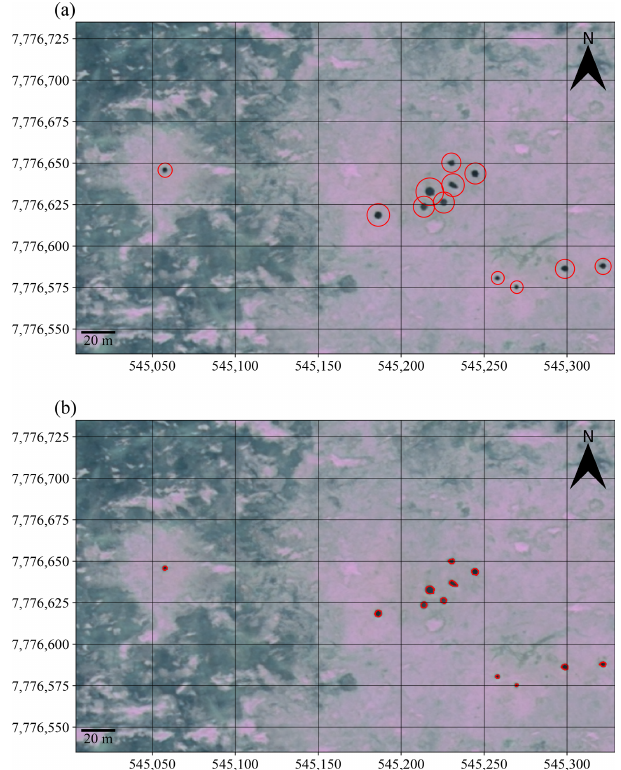
Figure 6. Examples of hole detection and classification results in lake ice of Lake Neyto on WorldView-2 true-colour composites ac- quired on 22 May 2016. (a) Examples of detected holes (red circles) from the blob-detection method. Radii of circles are scaled propor- tionally to the standard deviation of the LoG kernel that detected the respective blob, enlarged for the visualisation. (b) Mapped holes (red outlines) from the watershed segmentation method. CRS: WGS 84 / UTM zone 42N.